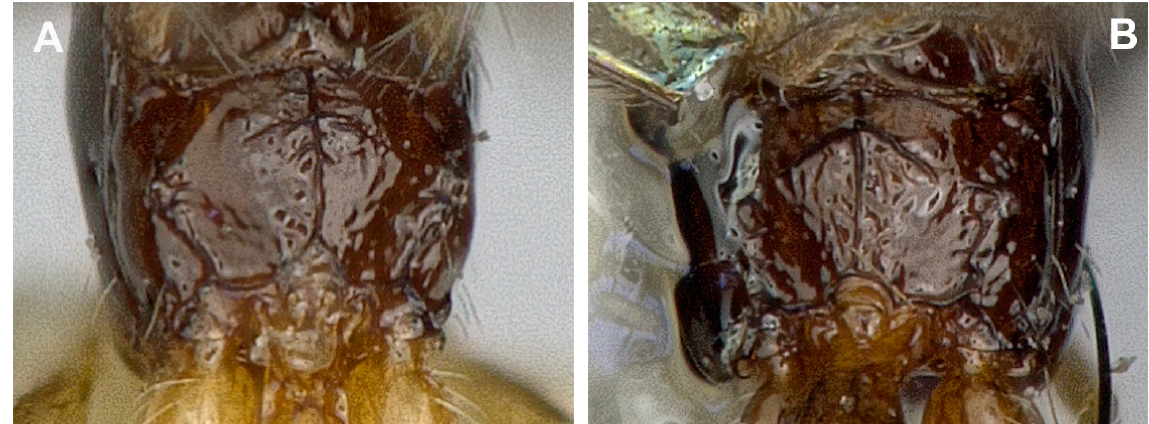
Fig. 10. Sculpture of propodeum. A . Dinotrema angusticorne (Fischer, 1969). B . Dinotrema bucculatricis (Fischer,